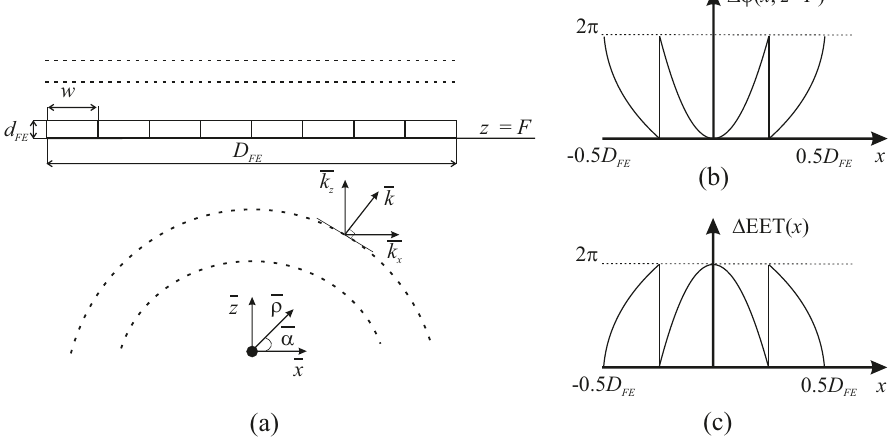
Figure 3. Schematic of proposed model: ( a ) simplified 2D model of the FE QOBD and ( b ) the phase distribution on the FE lens plane of the wave radiated by the feed antenna and ( c ) the FE lens